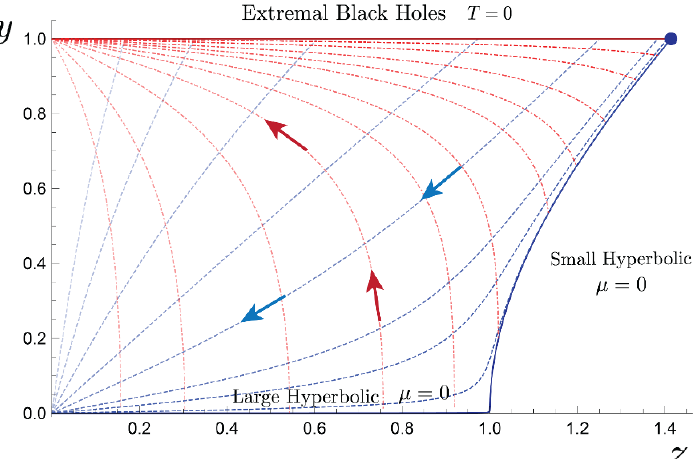
Figure 15 . Lines of constant (cid:22)R (dashed blue) and constant TR (dot-dashed red) for the hyperbolic black hole in d = 4, with y = r (cid:0) and z = L . The temperature and chemical potential increase as r + r + one moves towards the left, as indicated by the arrows. The line of extremal black holes at y = 1 with (cid:12)nite chemical potential has states with in(cid:12)nite complexity. However, the extremal black p hole represented by the blue dot with coordinates y = 1 ; z = 2 is the small uncharged extremal hyperbolic black hole, with zero chemical potential and (cid:12)nite complexity (using the CA proposal). sponding ‘extremal’ thermo(cid:12)eld double states (4.4) at zero temperature and (cid:12)nite